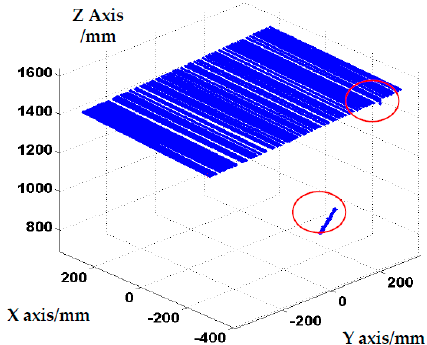
Figure 11. Reconstruction results without global boundary constraint. Sensors 2017 , 17 , 40